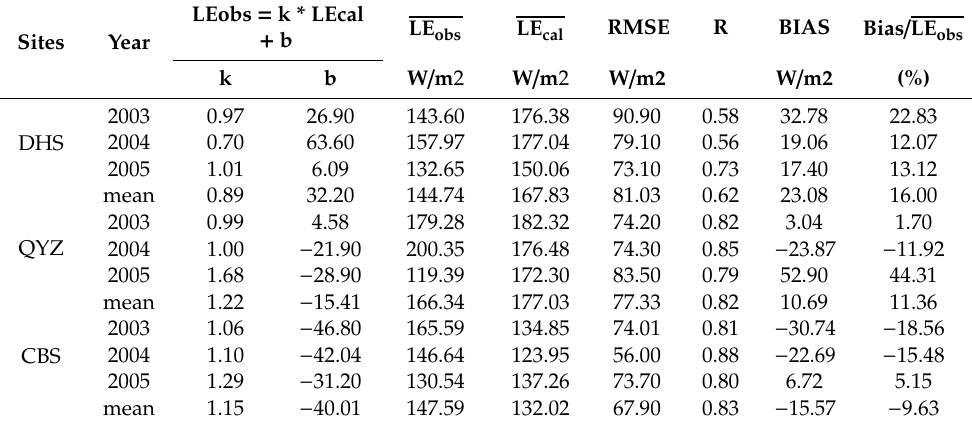
Figure 6. Time series of in-situ LE (LE obs ), estimated LE (LE cal ), and their differences at three forest sites from 2003 to 2005. LE obs was averaged over 2 hours around the satellite overpass. The dashed lines are ±150 Wm -2 .